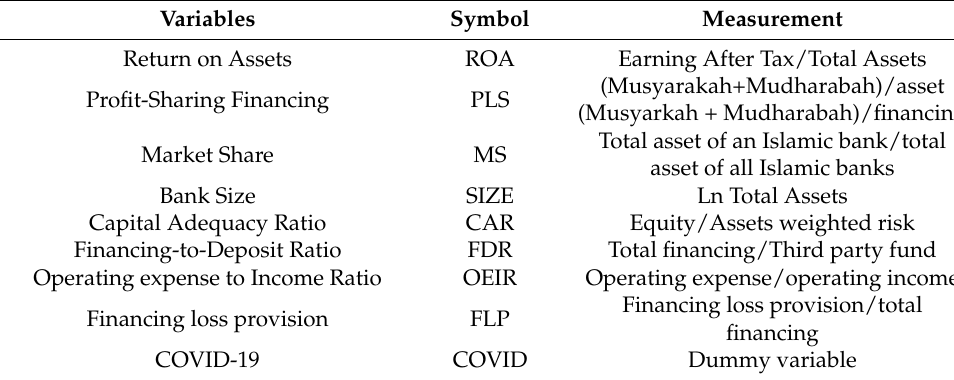
Table 1. Variables and measurement. Variables Symbol